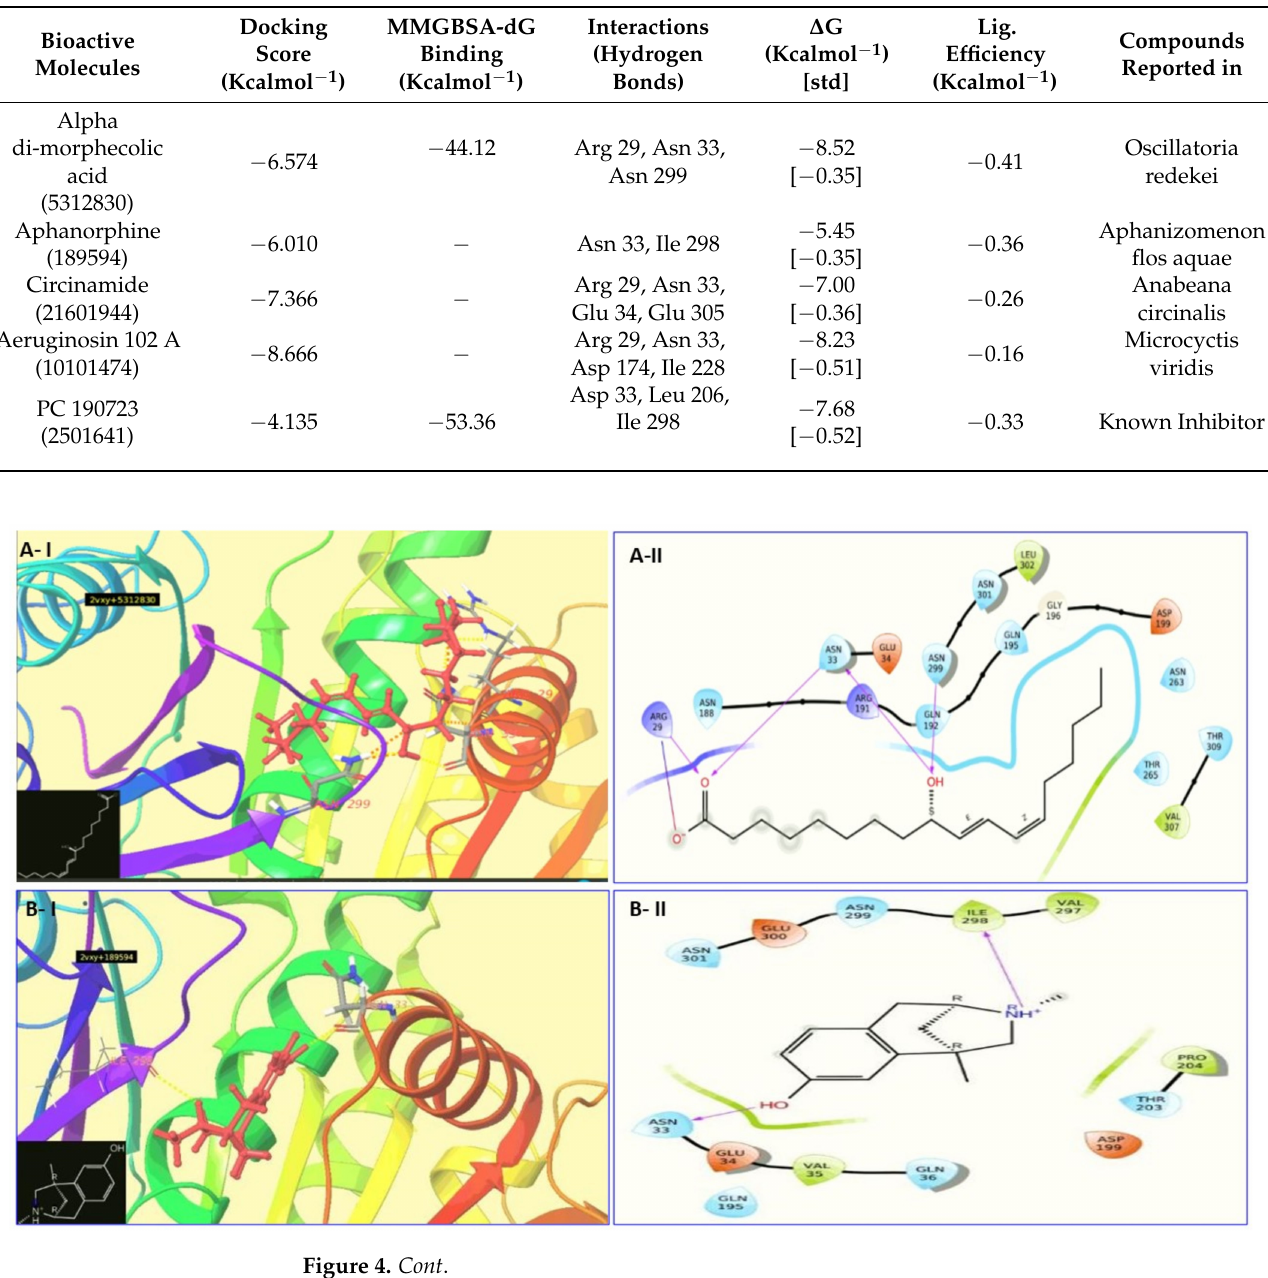
Table 1. Summary of docking ligand with Fts-Z protein of B. subtilis ; information about compounds’ source and reported activity with reference.